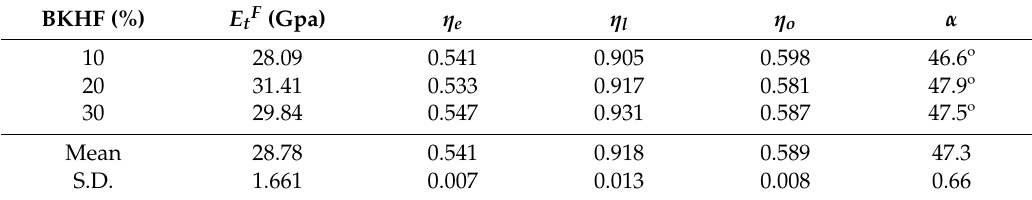
Table 2. Intrinsic Young’s modulus of the bleached kraft hardwood fibers (BKHF) and micromechanics parameters for a modified rule of mixtures of the Young’s modulus of the composites BKHF (%) E tF (Gpa) η e η l η o α 10 28.09 0.541